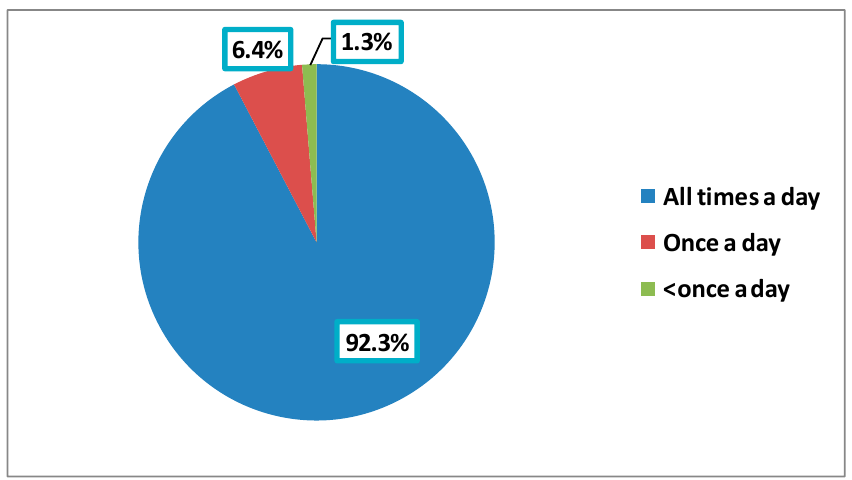
Figure 2. “ How often do you use social media?”, as answered by the participants.